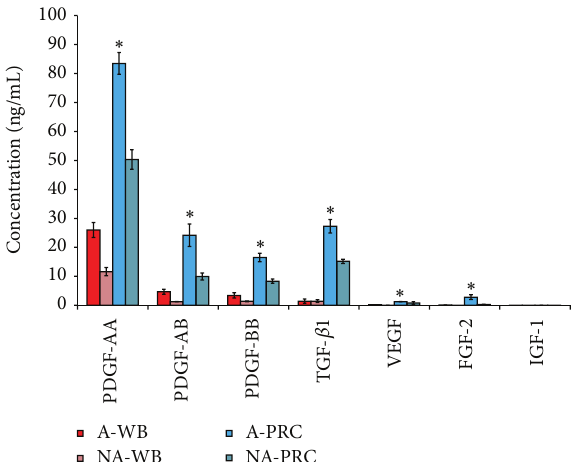
Figure 3: Concentration of various growth factors released in whole blood and PRC (before and after activation). The growth factors were significantly higher in activated PRC compared to activated whole blood ( ∗ 𝑃 ≤ 0.05 ).